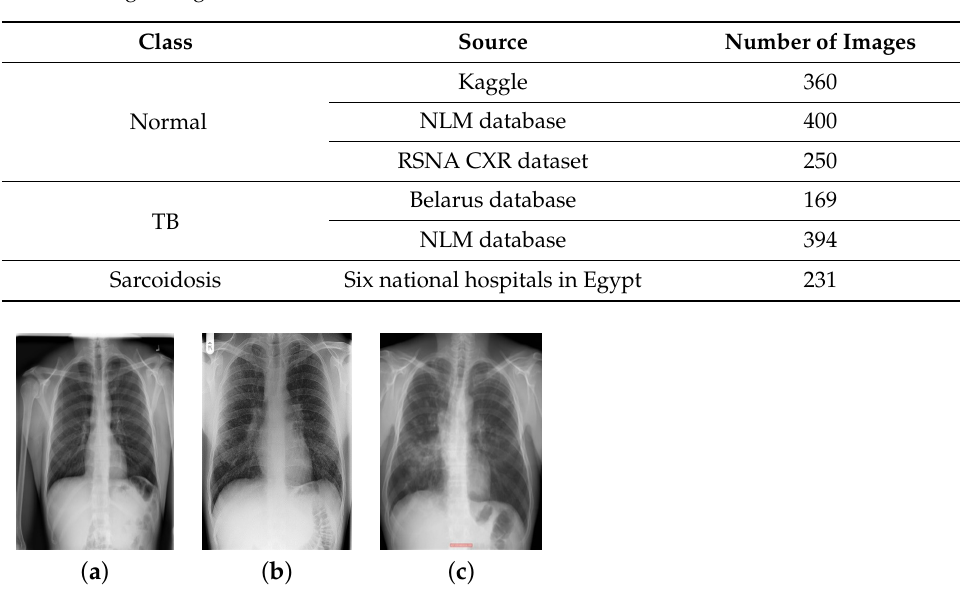
Table 1. Image categories and their collection sources.